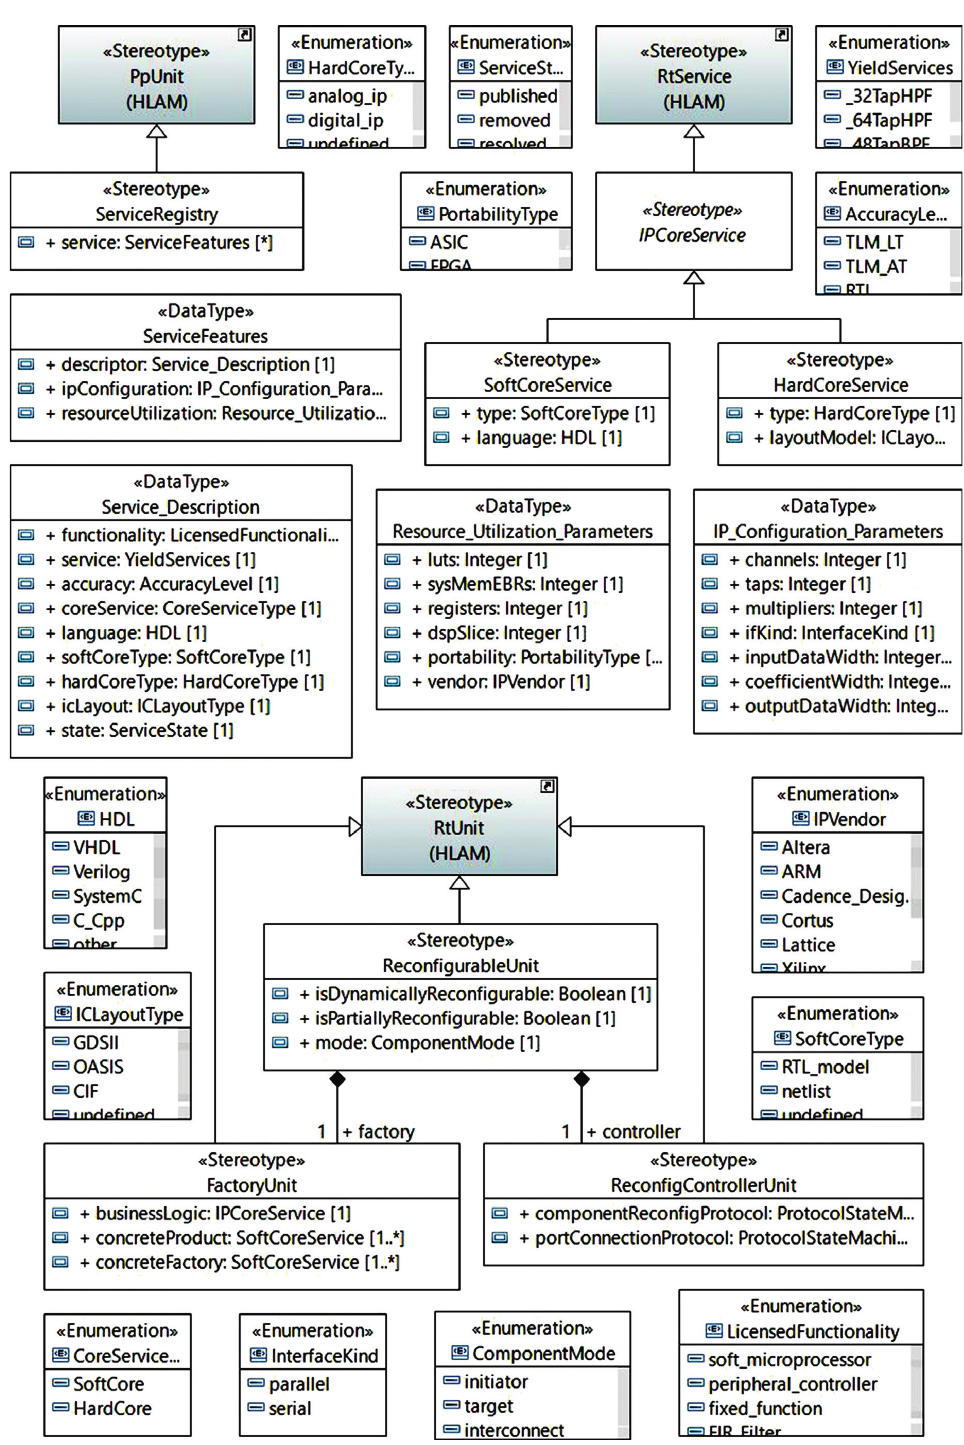
Figure 5: Extended HLAM